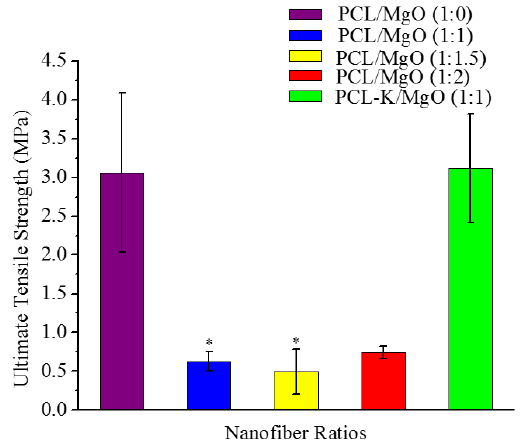
Figure 5. Ultimate tensile strength of PCL/MgO and PCL-K/MgO nanofibers, n = 5. Asterisks denote statistical significance ( p < 0.05) compared to the PCL/MgO (1:0) nanofibers.